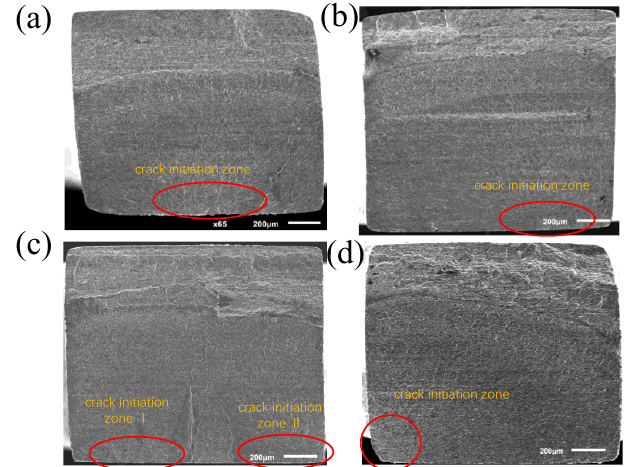
Figure 9. Pure bending fracture morphology: ( a ) σ a = 555 MPa, N f = 3.82 × 10 6 ( b ) σ a = 435 MPa, N f = 1.69 × 10 7 ; ( c ) σ a = 335 MPa, N f = 1.47 × 10 8 ; ( d ) σ a = 305 MPa, N f = 5.41 × 10 8 .